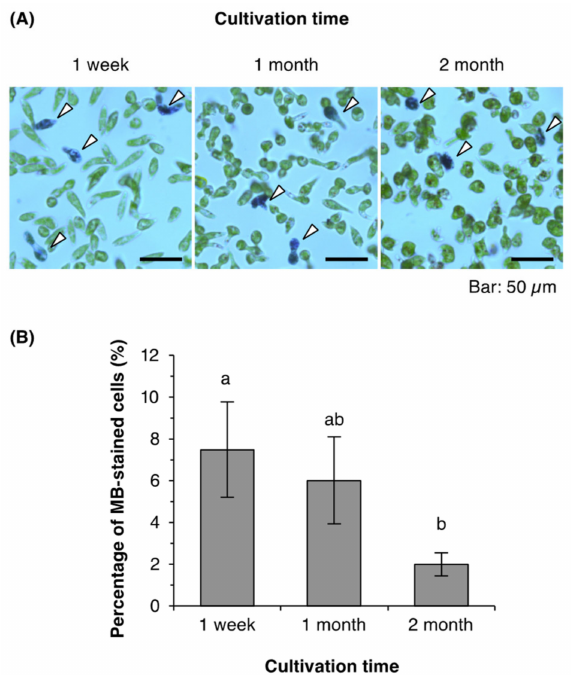
Figure 4. Viability of E. gracilis cells from young and old cultures. ( A ) Appearances of E. gracilis cells from 1-week-old, 1-month-old, and 2-month-old cultures stained with 0.04% methylene blue (MB). Arrowheads indicate MB-stained cells. ( B ) Percentages of MB-stained cells in the populations after washing prior to inoculation. Data are means ± SD ( n = 3). Bars labeled with the same letter do not differ significantly from each other (Tukey’s multiple range test, p <